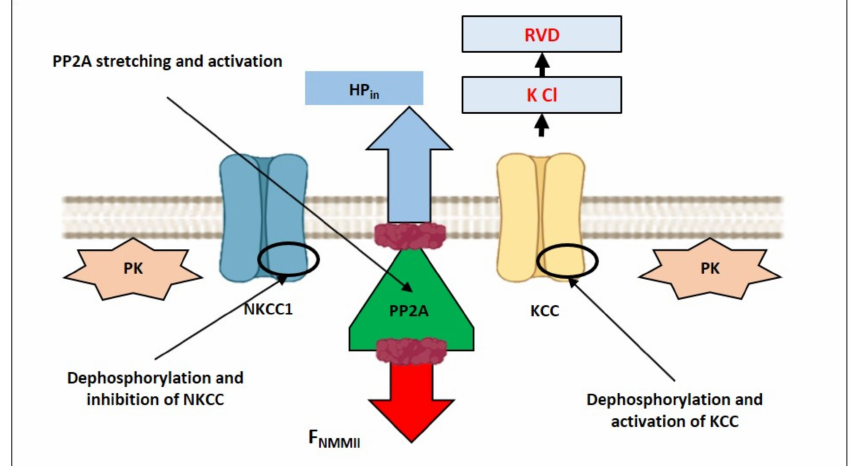
Figure 10. Illustration of hypothetical activation of mechanosensitive PP2A during cell swelling. During cell swelling PP2A can be stretched by HP in and F NMMII and thus activated. KCC would be activated by dephosphorylation by PP2A and would lead to RVD. In addition, dephosphorylation by PP2A would inhibit